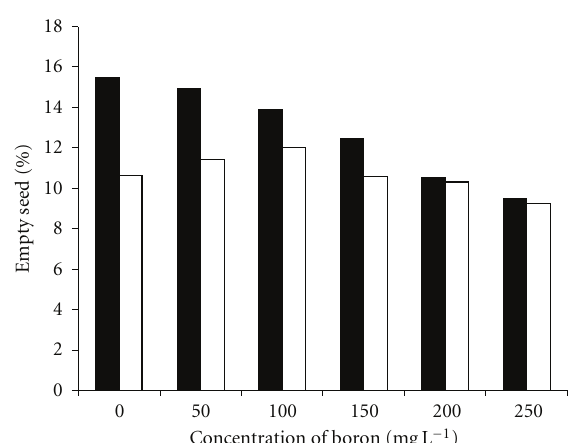
Figure 5: E ff ect of foliar applied boron on empty seed percentage % in spring (filled columns) and autumn (open columns) sunflower crops. (LSD 0 . 05 1.6 and N.S, resp.).